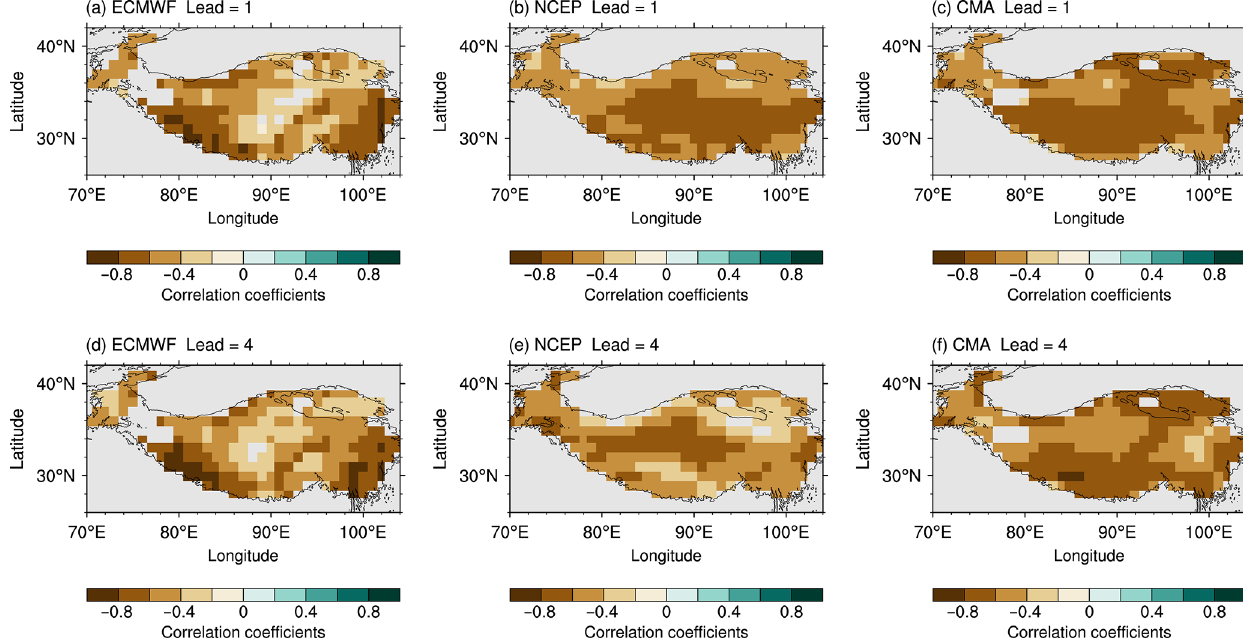
Figure 7. Spatial pattern of correlations between the snow cover fraction and the surface air temperature with a lead of 1 week in (a) ECMWF, (b) NCEP and (c) CMA. Only significant correlations at the 0.01 level are displayed. Panels (d) – (f) are similar to panels (a) – (c) but for forecasting with a lead of 4 weeks. The map of the Tibetan Plateau was created by using Global Relief Model data of ETOPO1 (topographic data free to the public, https://doi.org/10.7289/V5C8276M, National Geophysical Data Center, 2020).